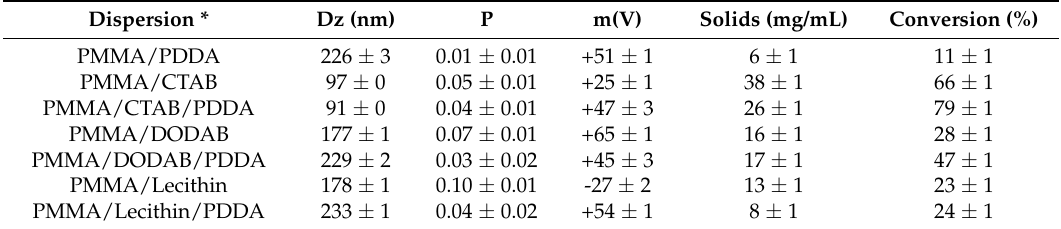
Table 4. The effect of PDDA, surfactants, and lipids on NPs size (Dz), polydispersity (P), and zeta-potential ( ζ ) on the stabilization of MMA droplets in water and the improvement of solid contents and conversion percentiles for NPs synthesis.